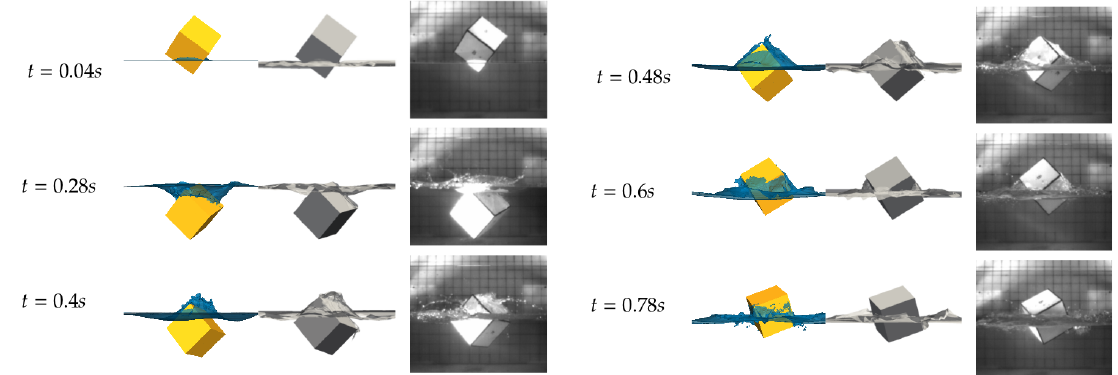
Figure 13. Freely falling cube: results for six selected time steps.